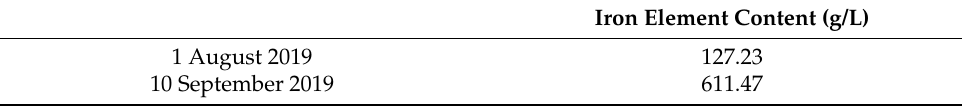
Table 2. Iron element content of the desalination buffer in NH.W2 in August and September 2019.